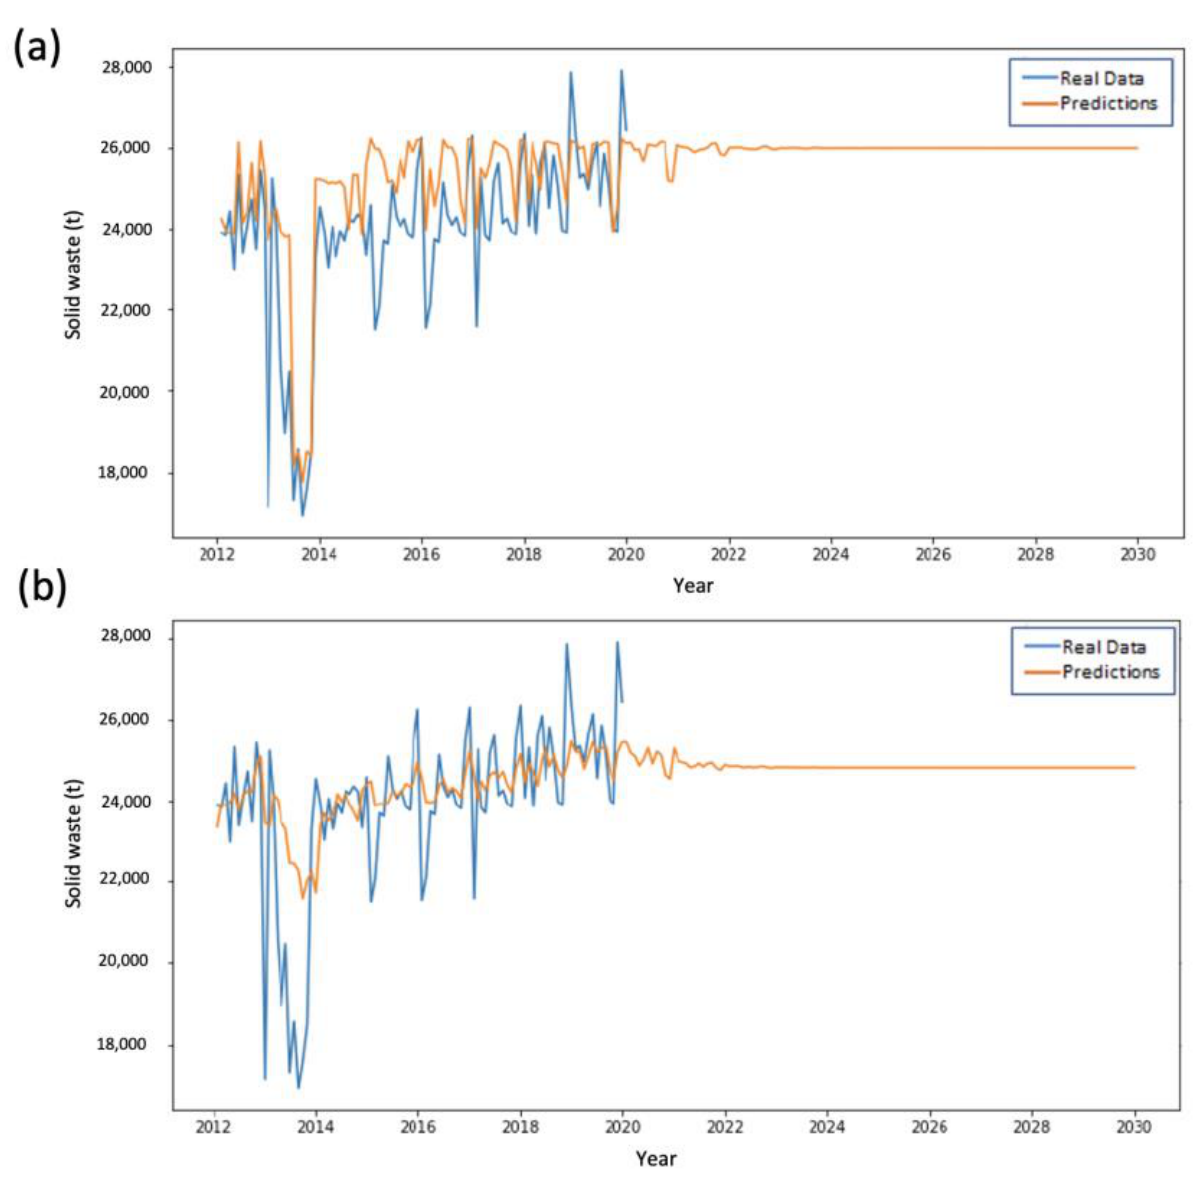
Figure 8. Performance comparison in the training and prediction for ESA Zone 4 using ( a ) LSTM and ( b ) SVMs.